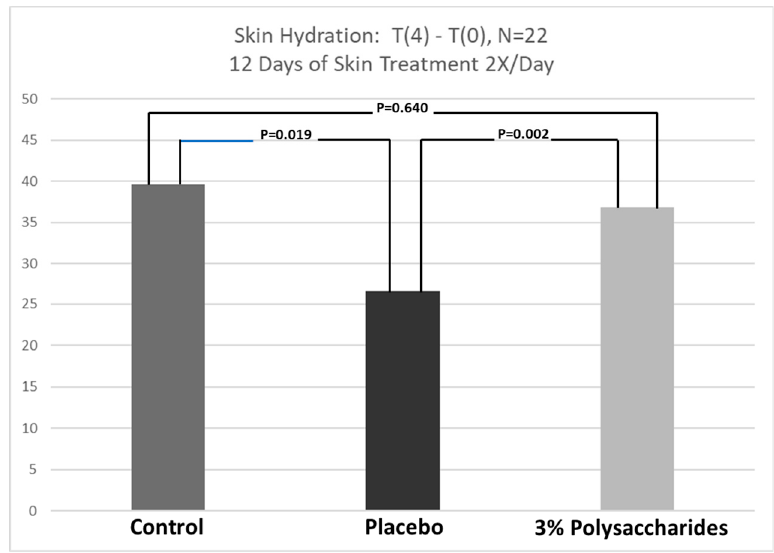
Figure 4. Results of skin hydration ( µ Siemans) measurements. Dark grey is the untreated control, black is the retinol placebo-treated and light grey is the polysaccharide active-treated sites. N = 22, p ≤